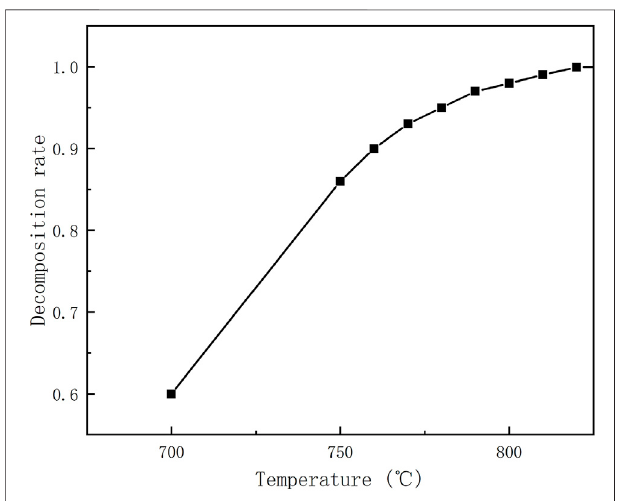
FIGURE 9 | Experimental data of ammonia